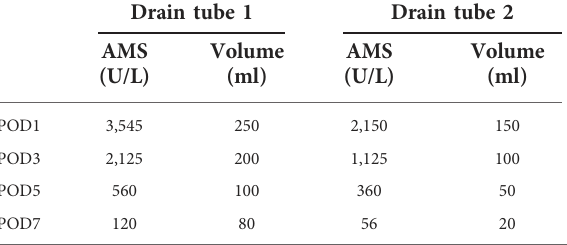
POD, postoperative day.